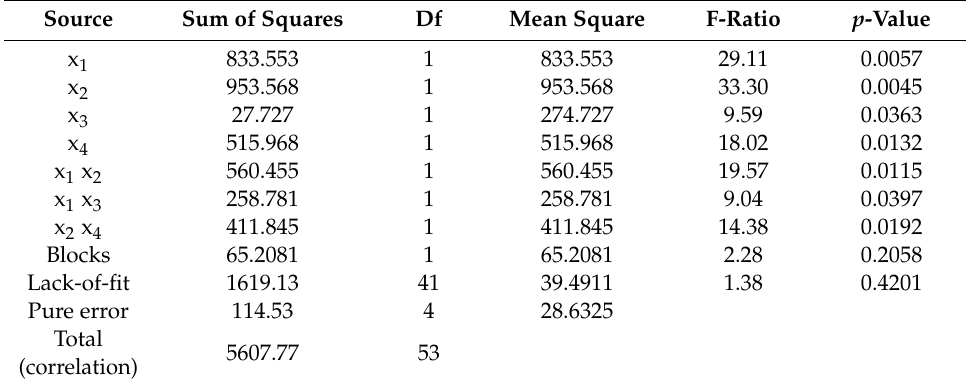
Table 4. Analysis of variance: the empirical model for predicting dimethyl sulfide